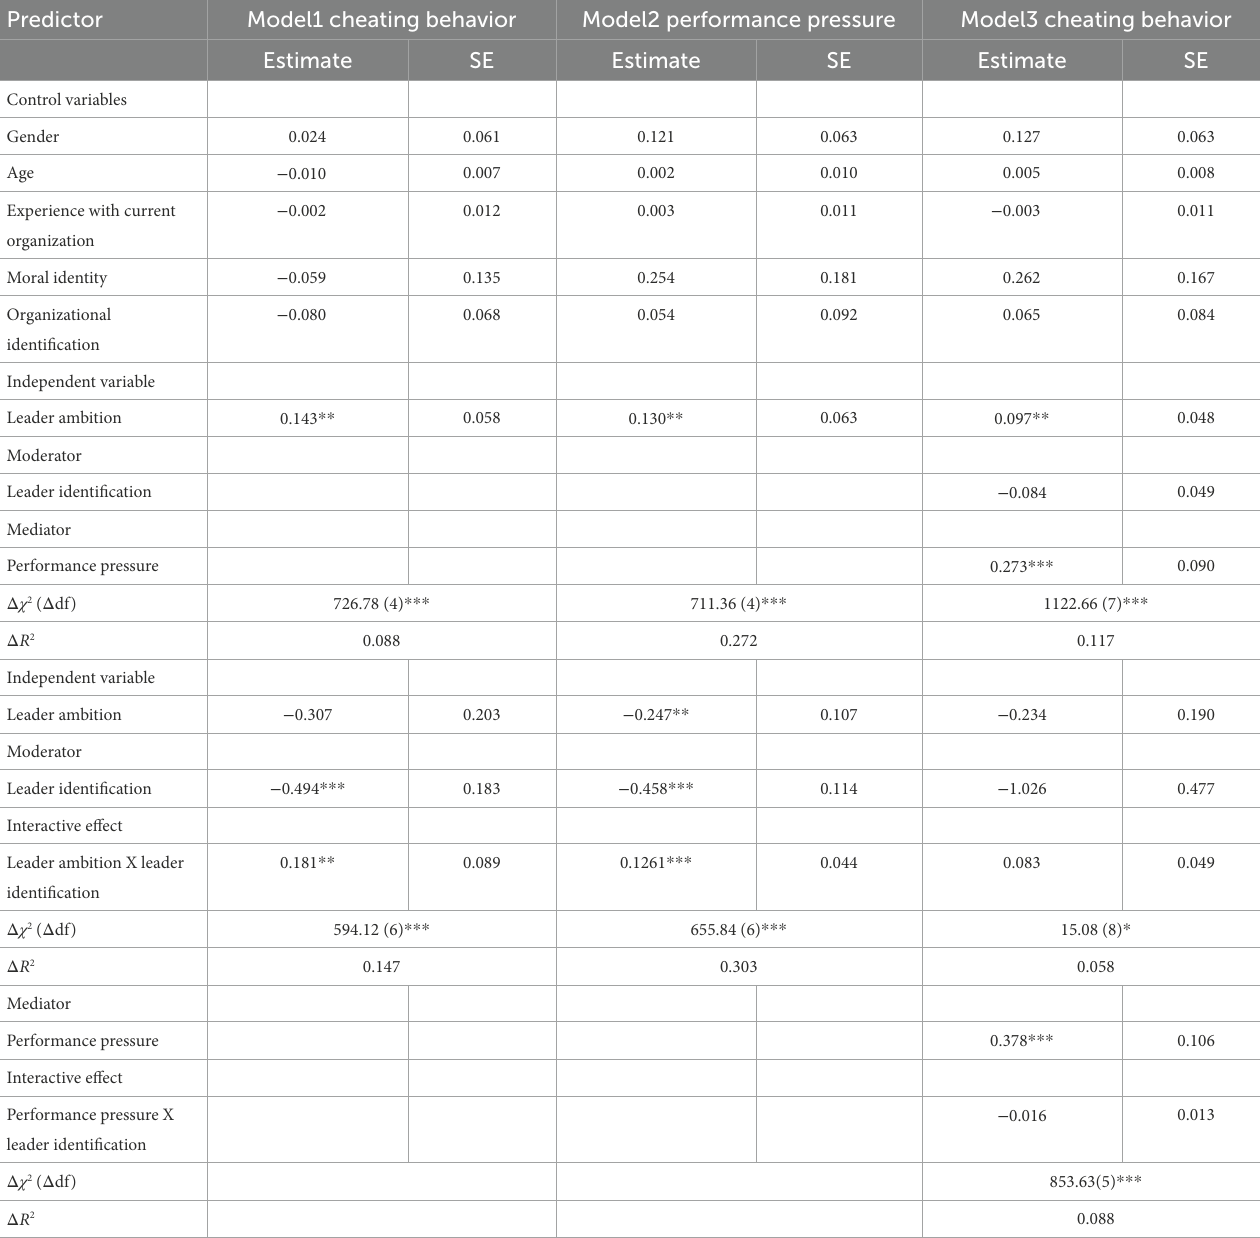
TABLE 5 Study 2- summary of hierarchical random coefficient regression analysis results.